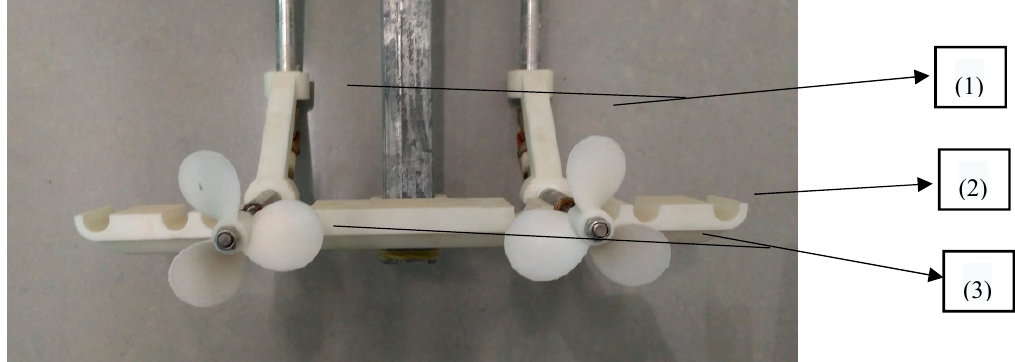
Figure 5. 3D printed twin-propeller and the horizontal support with grooves. (1) Torque conversion system; (2) Grooved support; and, (3) Twin-propeller.